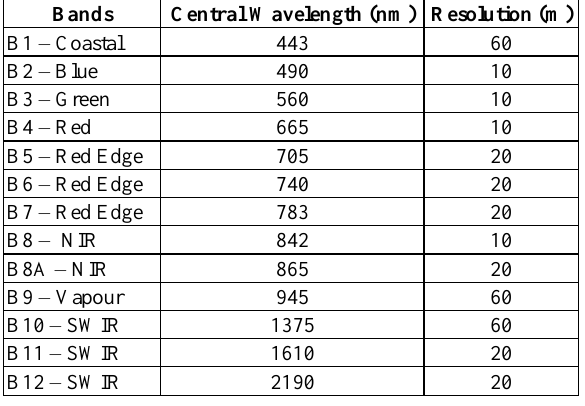
Table 1. Main characteristics of Sentinell-2A images.